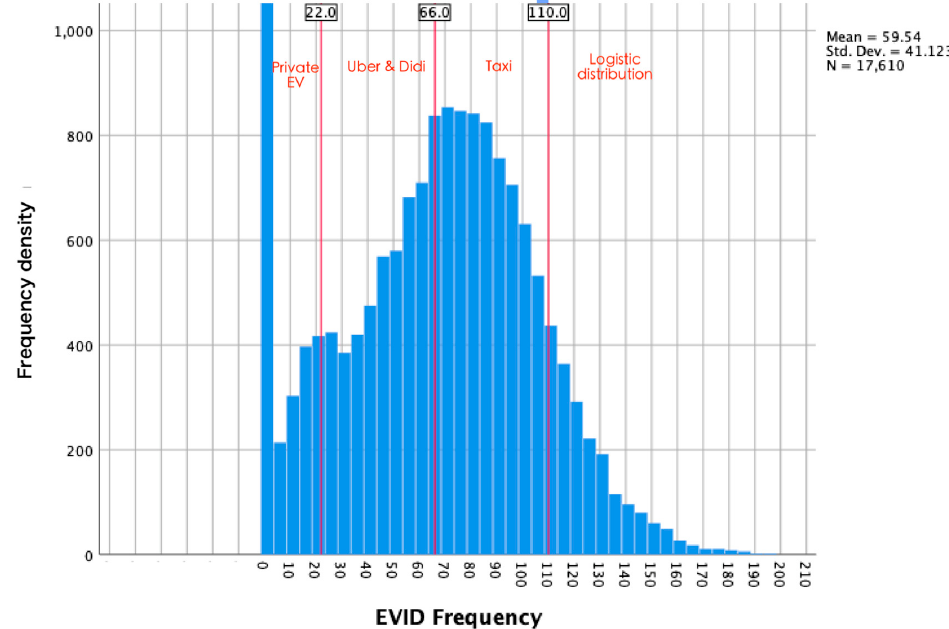
Figure 3. Charging frequency density distribution map for typical EV operating modes in 2021.